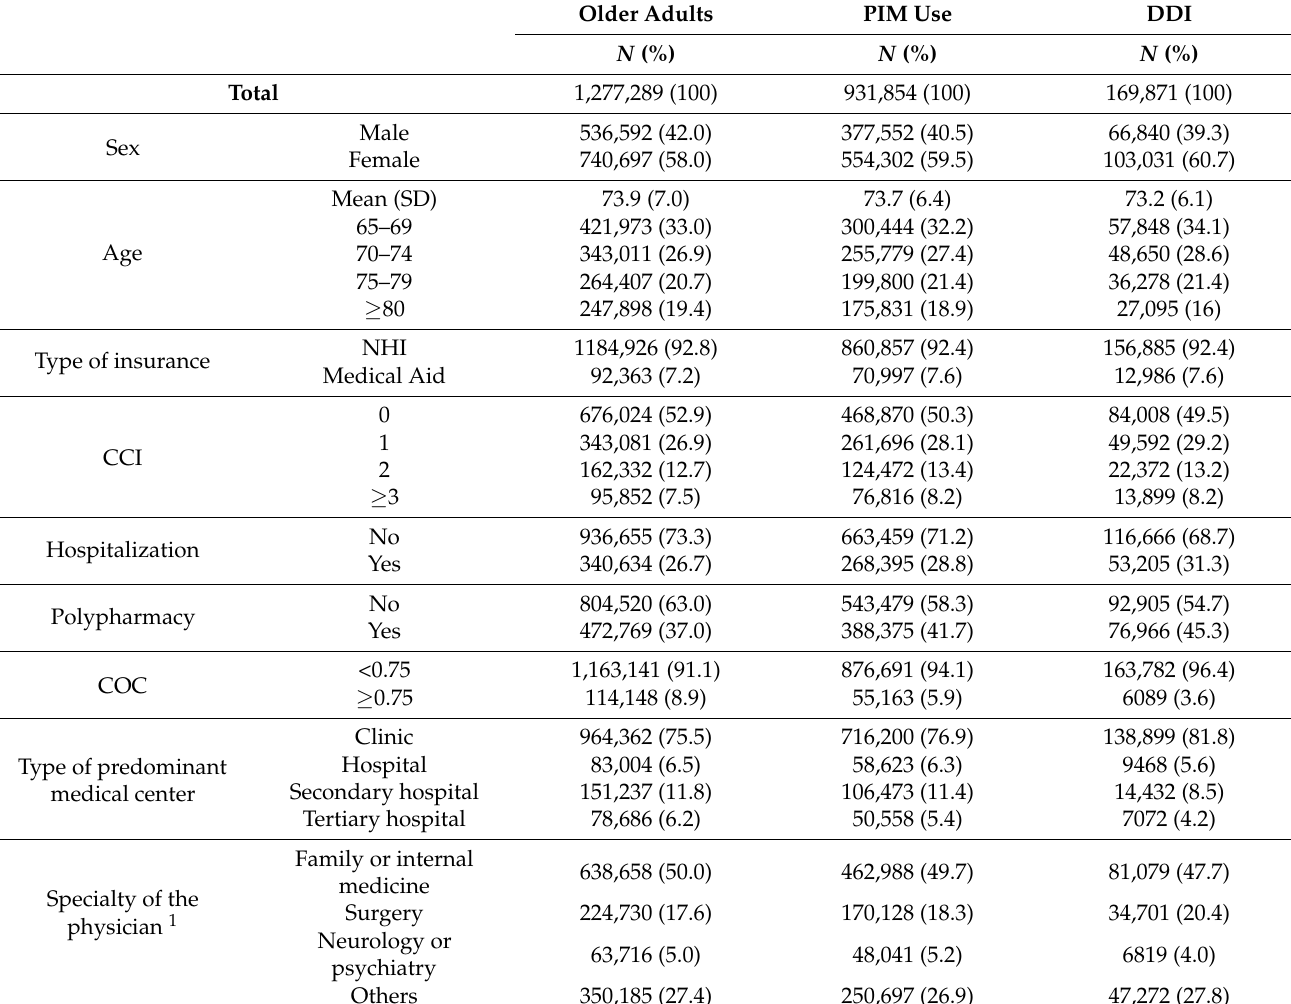
Table 1. Characteristics of older adults and prevalence of PIM use or drug–drug